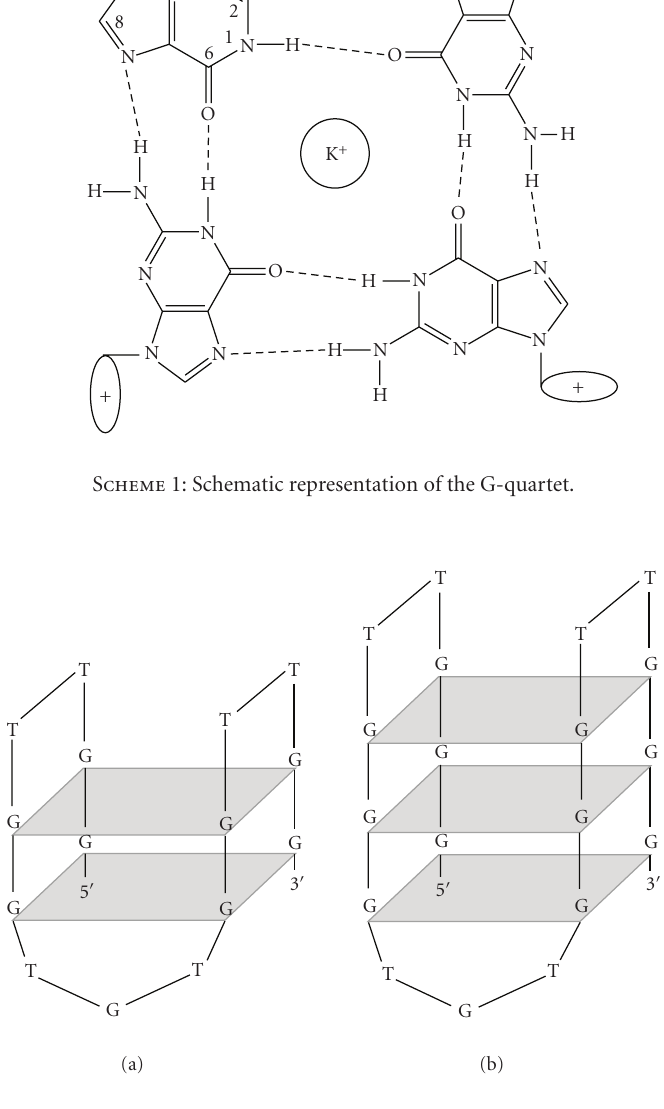
Scheme 2: Schematic representation of the antiparallel G-quadruplex structures of (a) TBA and (b)